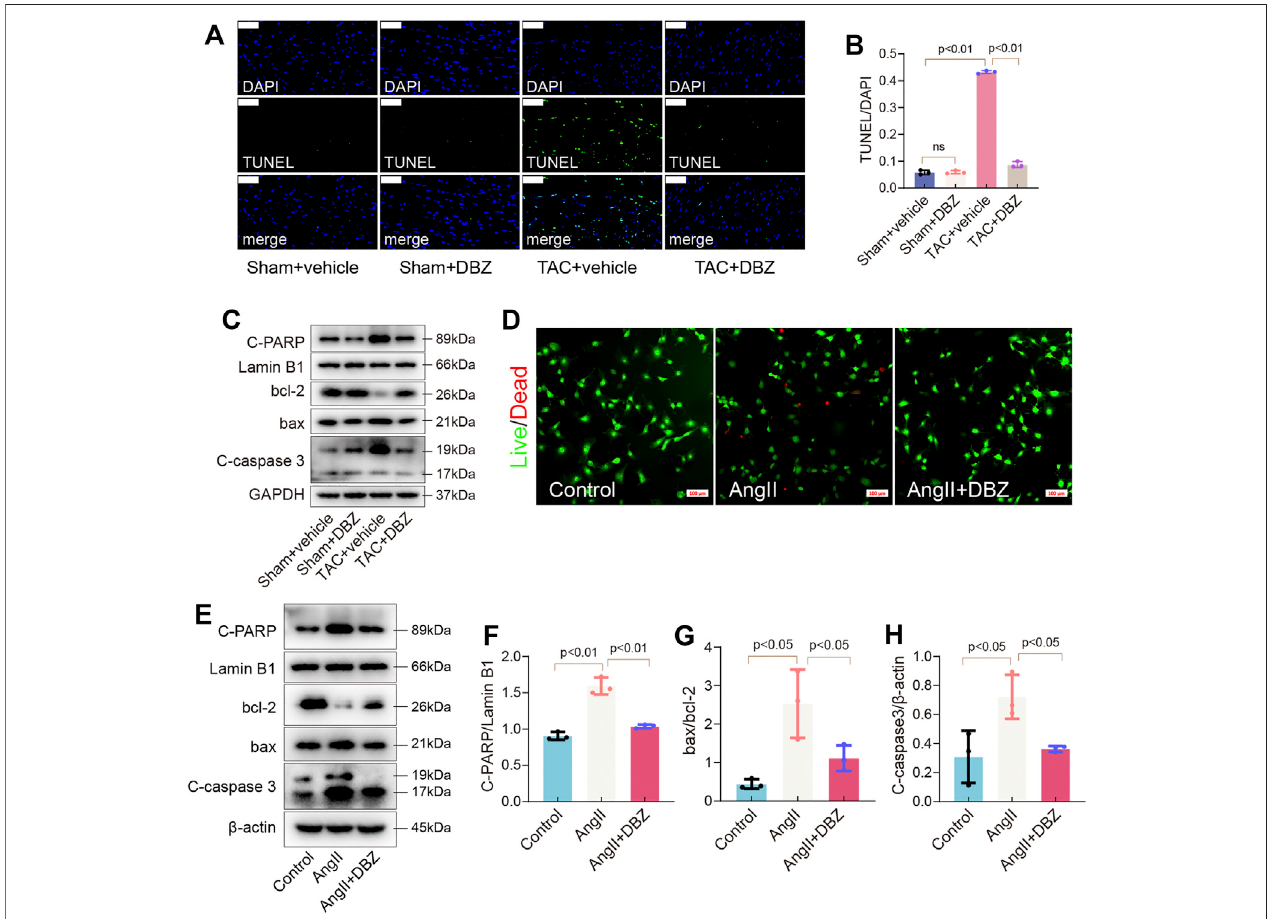
FIGURE 6 | DBZ ameliorated apoptosis of cardiomyocytes. (A,B) The apoptosis level detected by TUNEL staining and quanti fi cation. Scale bars = 50 μ m. n = 3. (C) Representative Western blotting assay of C-PARP, bcl-2, bax and C-caspase3 expression. (D) Representative Live/Dead staining images. Scale bars = 100 μ m. (E – H) Representative Western blotting assay and quanti fi cation of C-PARP, bcl-2, bax and C-caspase3. n = 3. Results are expressed as means ± SD. Statistical analyses were performed by one-way ANOVA followed by Bonferroni ’ s post-hoc